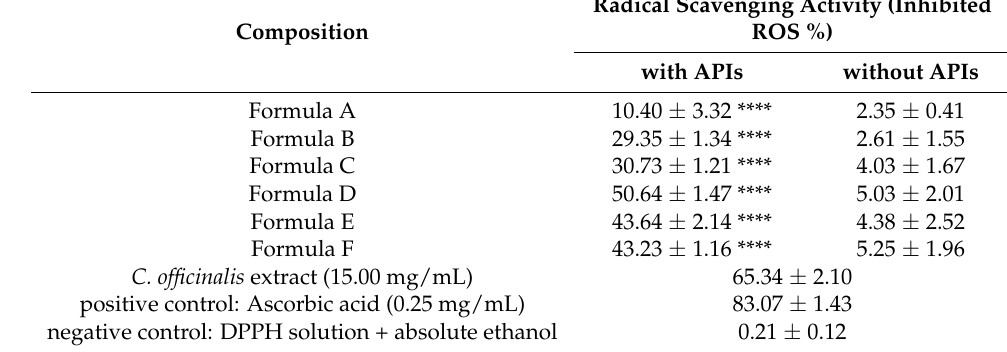
Table 9. In vitro free radical scavenging activity of the formulations with or without APIs and the antioxidant activity of C. officinalis extract (15 mg/mL). As positive control ascorbic (0.25 mg/mL) dissolved in ethanol (96%) was applied. The negative control was 2.0 mL of DPPH solution (0.06 mM) diluted with 1.0 mL absolute ethanol. Results presented as mean radical scavenging activity (inhibited ROS %) ± SD. Ordinary one-way ANOVA and Tukey’s multiple comparison tests were performed to compare compositions with or without APIs. Significant differences are marked with **** ( p < 0.0001), showing the significance in the case of formulations containing APIs and the same formulation without